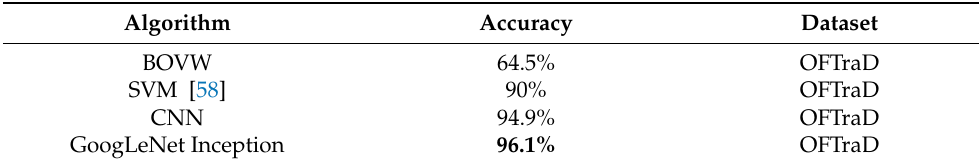
Table 1. Tracking accuracy using different